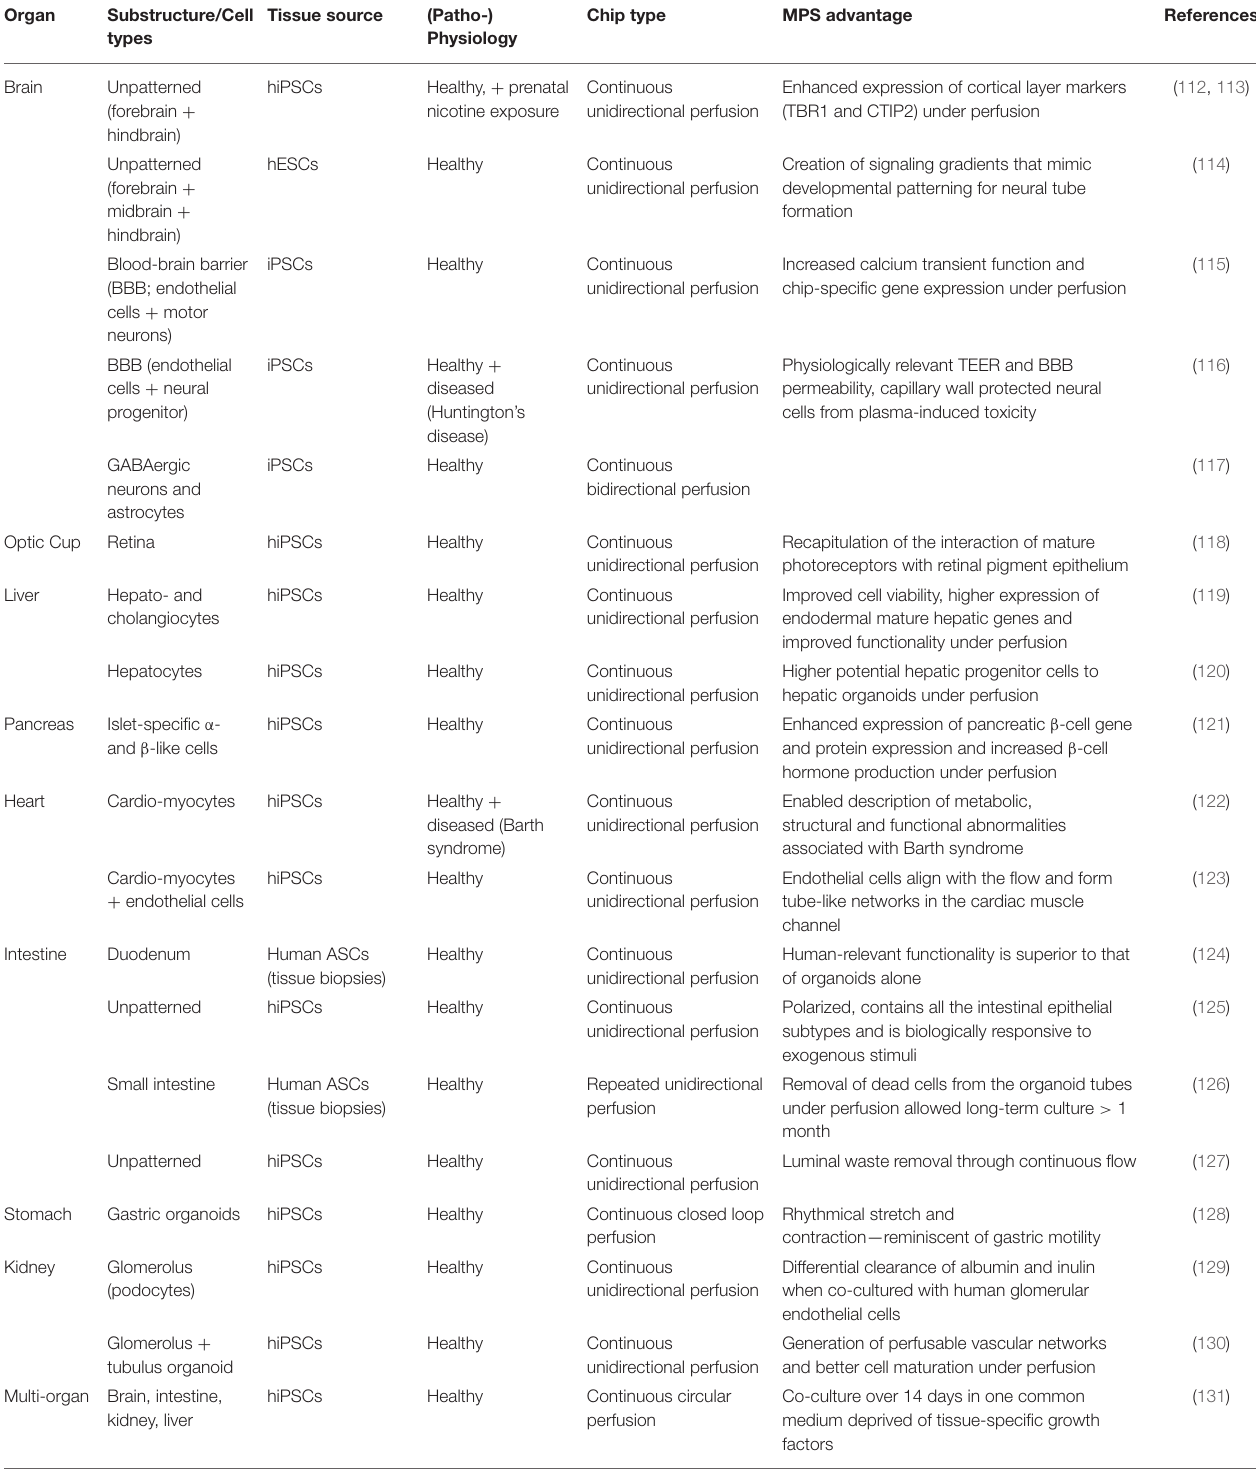
TABLE 2 | Examples of the MPS-based models established recapitulating functions of the key human organs.